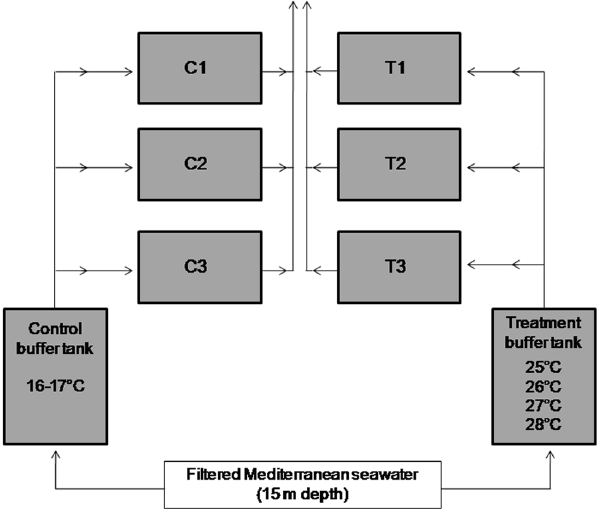
Figure 7. Experimental setting. Experimental setting of all the performed experiments. Control and Treatment sets where colonies were placed were composed by three replicates (C1, C2 and C3, and T1, T2 and T3 respectively) plus one large buffer tank which was supplied with filtered Mediterranean seawater and from there, water was pumped continuously into the experimental tanks. Buffer tanks were used to control the temperature of experimental